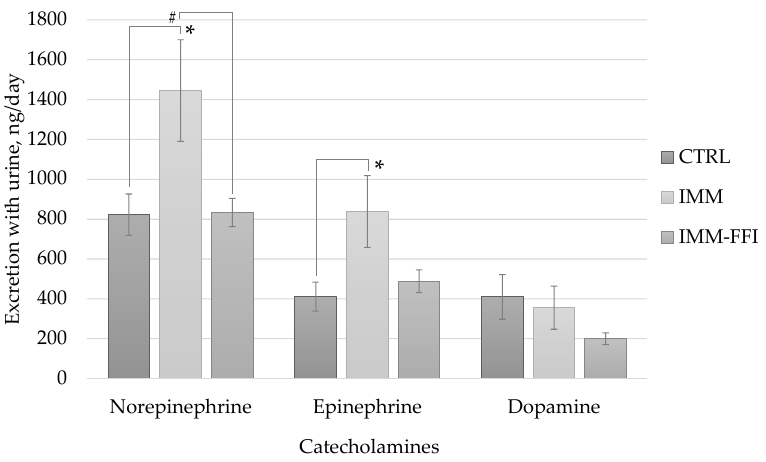
Figure 4. Daily urinary catecholamine excretion, ng/day. *—differences are significant compared with the CTRL group, p < 0.05. #—differences are significant compared with the RUN group, p < 0.05.